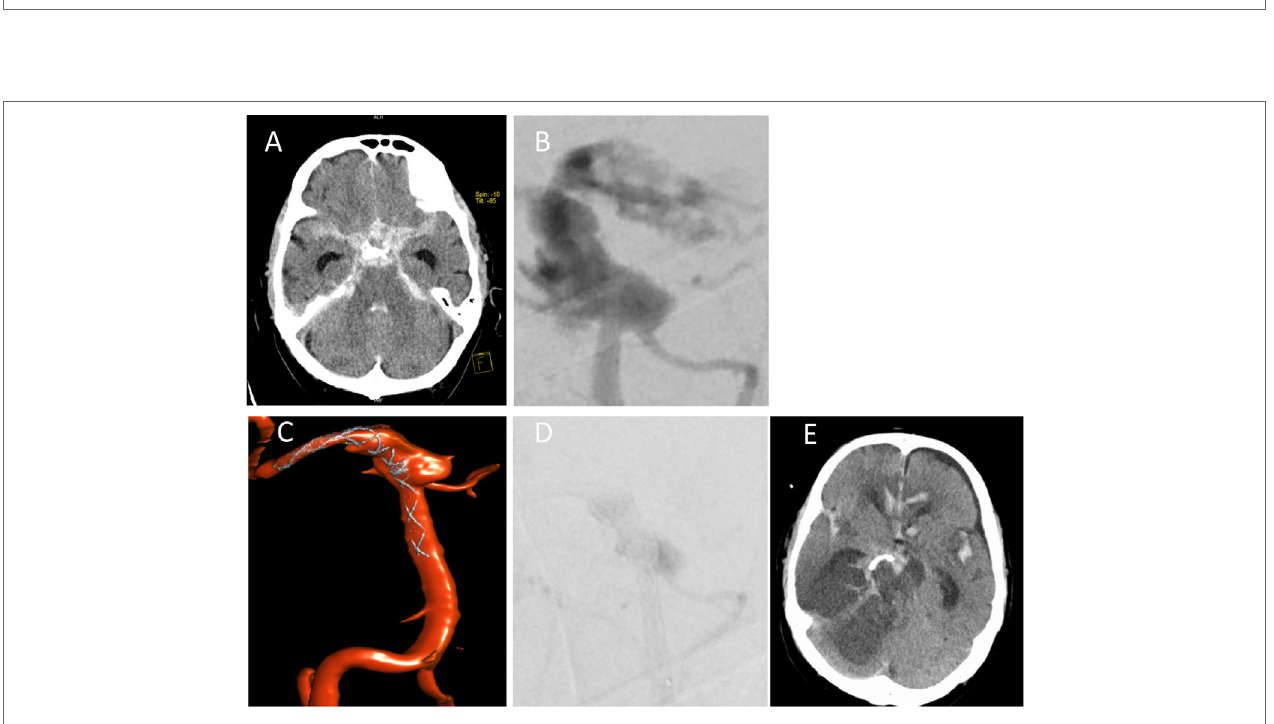
FIGURe 2 | Subarachnoidal hemorrhage from A. basilaris . (a) cCT on day 12 scan showing hemorrhage. (B,C) Digital subtraction angiography with intervention showing active bleeding (B) and insertion of flow diverting stent (C) . (D) Late arterial phase of DSA indicating starting thrombosis immediately after flow diverter implantation. (e) Follow-up cCT on day 17 shows demarcation of ischemic areas.